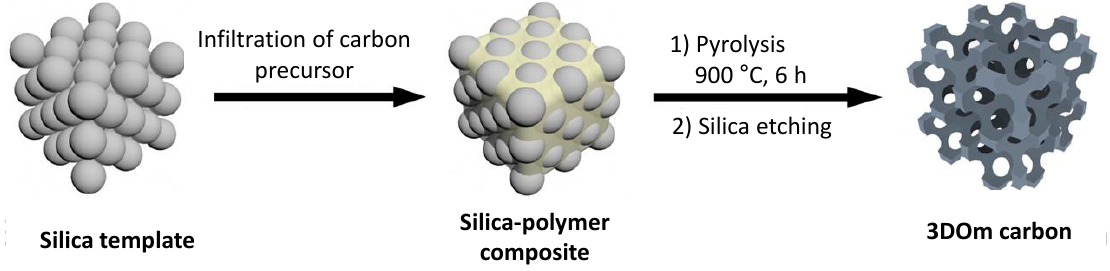
Figure 1. Schematic of fabrication of three-dimensionally ordered mesoporous (3DOm) carbon. With permission from [21]; Copyright 2013, American Chemical